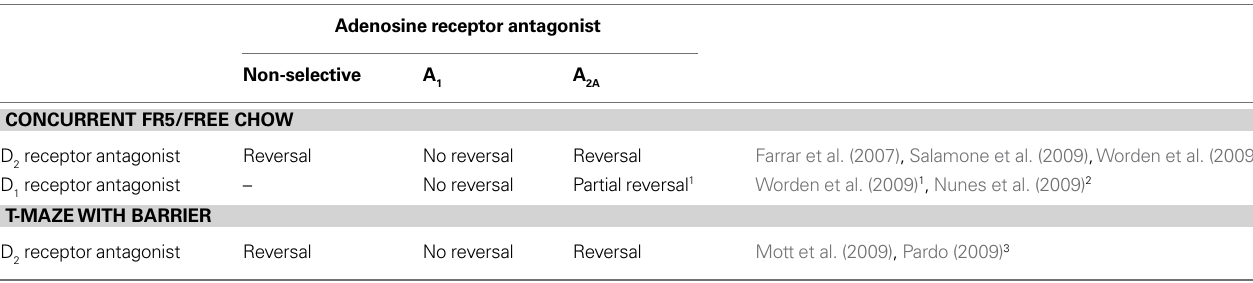
Table 1 | Interactions between dopamine and adenosine receptor antagonists. Adenosine receptor antagonist Non-selective